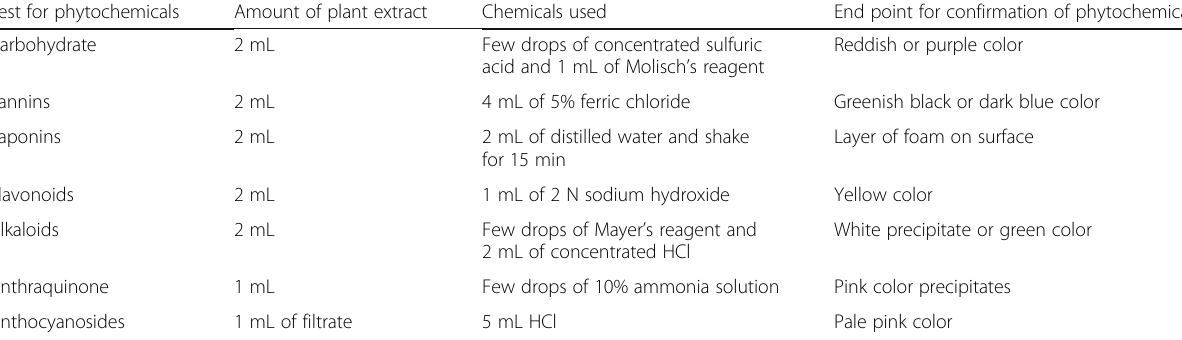
Table 2 Phytochemical screening analysis